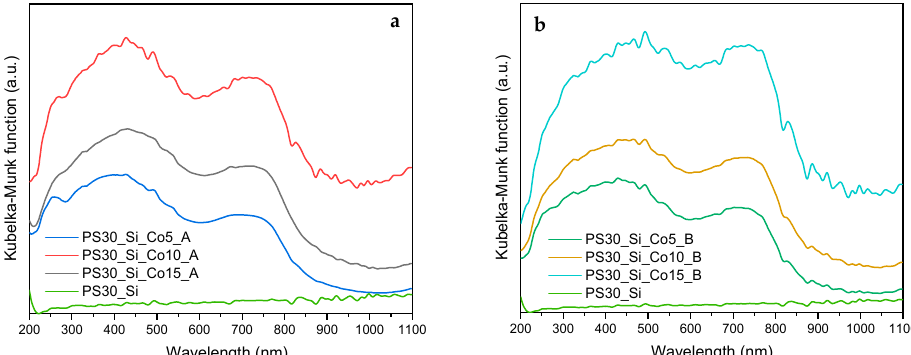
Figure 5. UV-Vis-DR spectra of PS30_Si-based catalysts synthesized in the path A ( a ) and B ( b ).